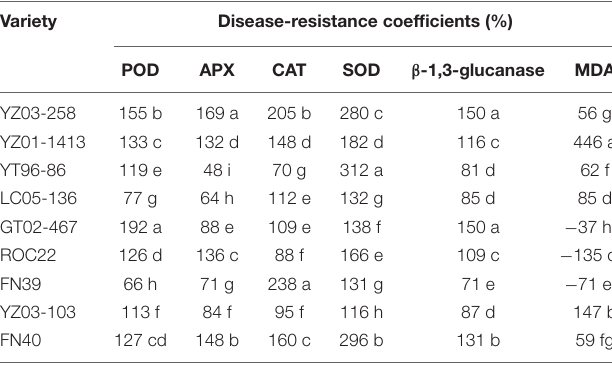
FIGURE 1 | Copy number variations in the smut pathogen with different sugarcane genotypes as indicated by TaqMan qRT-PCR analysis. A smut spore suspension of 5 × 10 6 spores/mL was inoculated by puncturing the sugarcane bud with a needle. The bud samples were collected at the early stages of 0, 1, 3, and 7 days and analyzed by TaqMan qRT-PCR technique. Copy numbers of smut pathogen were calculated with the equation of the linear regression line. Error bars were represented as standard error. YZ03-258, YZ01-1413, YT96-86, and LC05-136 were smut resistant cultivars. GT02-467, ROC22, and FN39 were medium susceptible cultivars. YZ03-103 and FN40 were susceptible cultivars.